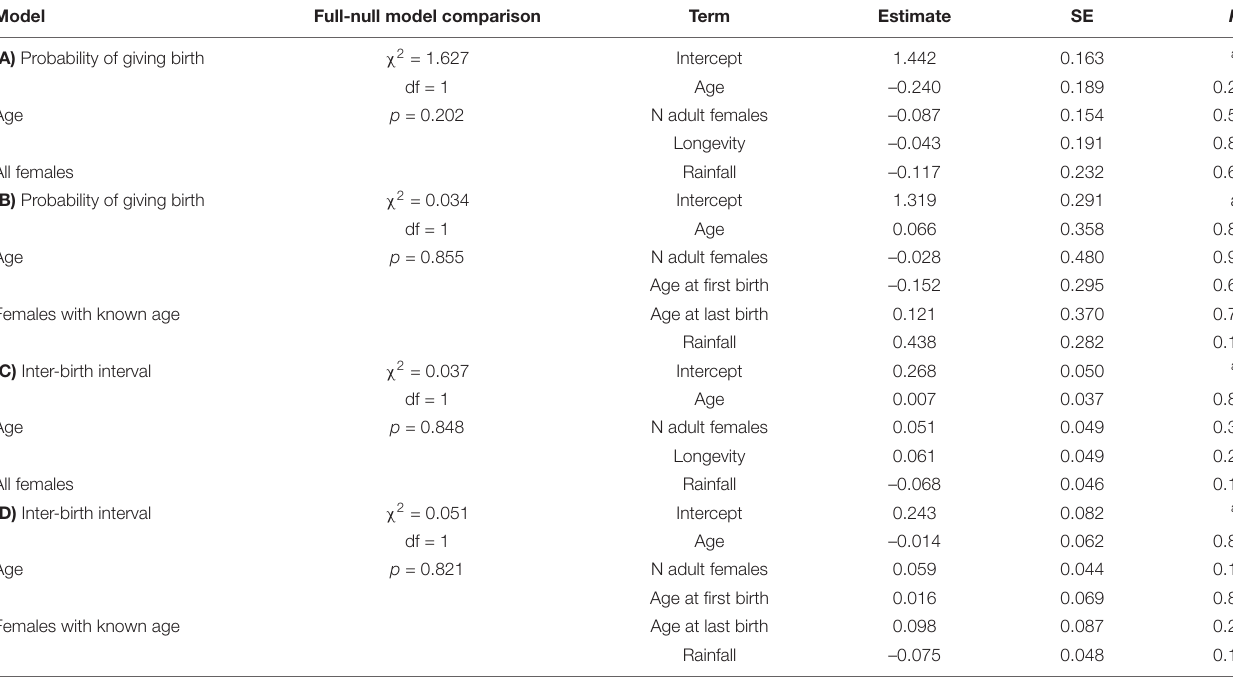
TABLE 2 | Results of the models in wild Verreaux’s sifakas on (A) the probability of giving birth for all females, (B) for female’s with known age, and variation in interbirth intervals (C) for all females and (D) for females with known age.